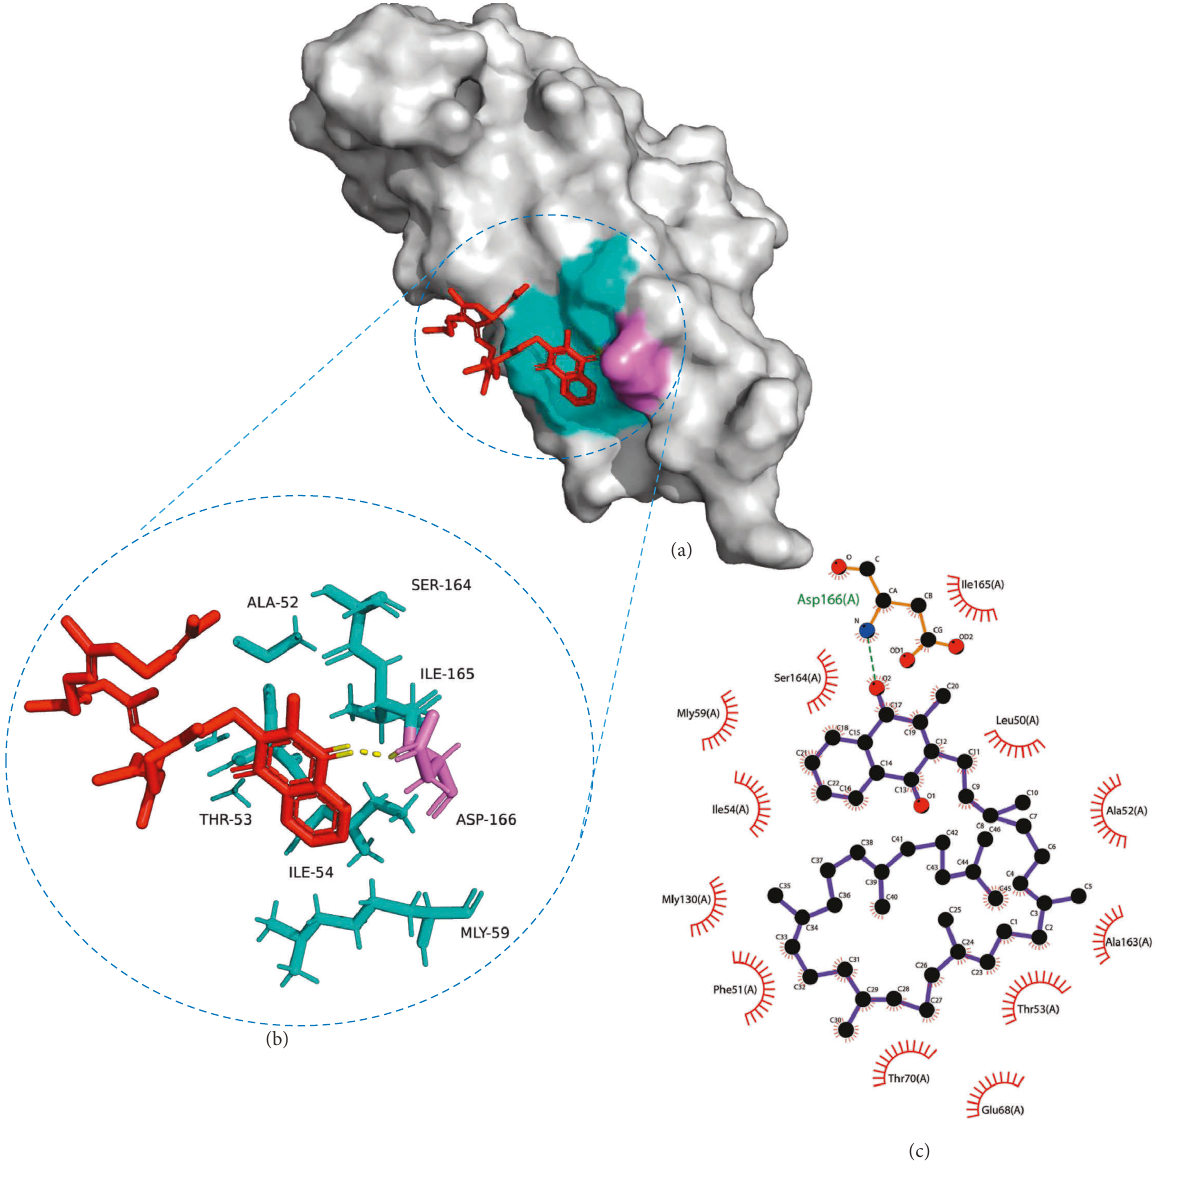
Figure 1: Prediction of the BslA protein binding site to menaquinone-7. (a) Surface model of menaquinone-7 binding to BslA proteins; (b) Stick model of hydrogen bonding between menaquinone-7 and BslA proteins; (c) 2D pose of protein-ligand